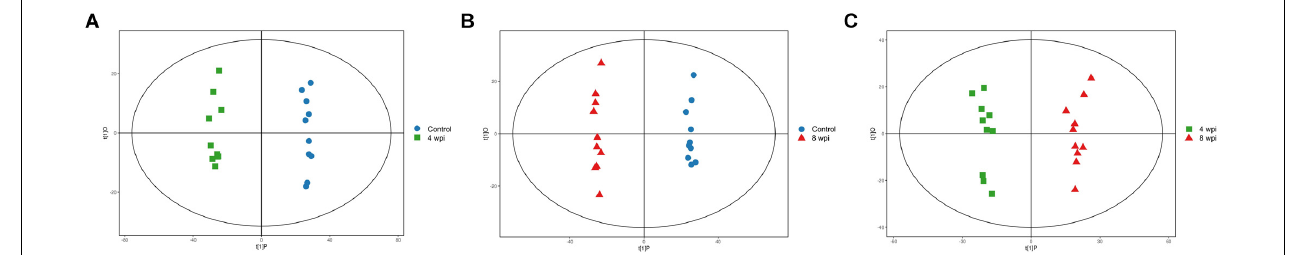
FIGURE 1 | Orthogonal partial least squares discriminant analysis (OPLS-DA) score scatter plots of splenic metabolites during C. sinensis infection in ESI+ mode. (A) OPLS-DA score scatter plot of 4 wpi vs control in ESI+ mode; (B) OPLS-DA score scatter plot of 8 wpi vs control in ESI+ mode; (C) OPLS-DA score scatter plot of 8 vs 4 wpi in ESI+ mode. Control, healthy control; 4 wpi, 4 weeks post infection; 8 wpi, 8 weeks post infection.